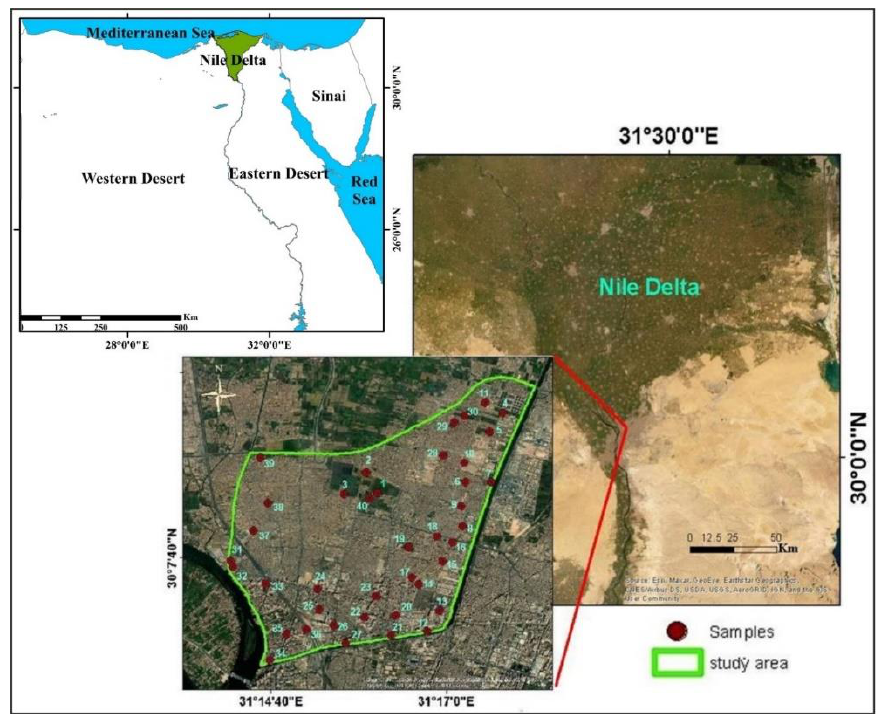
Figure 1. Satellite images showing the location of the study area and sampling sites.